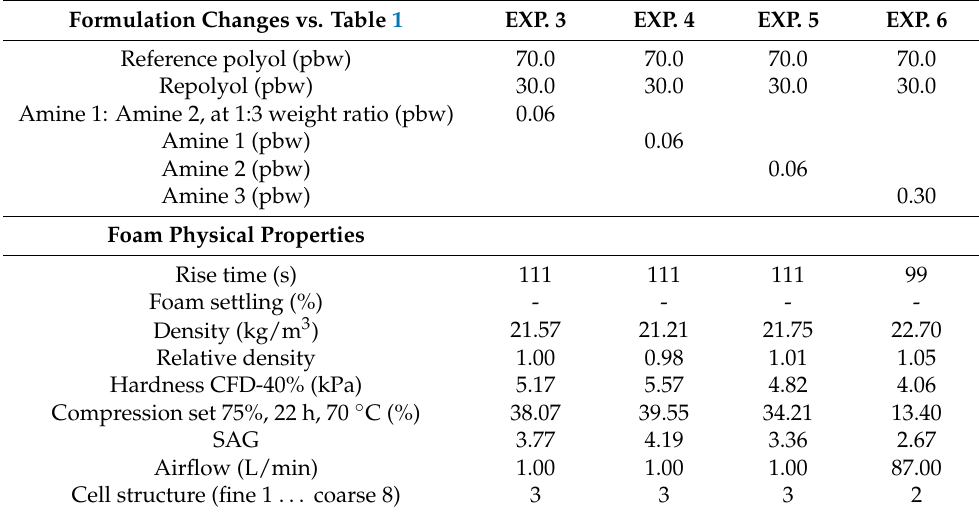
Table 5. The influence of the tertiary amine catalyst on the properties of the flexible PU foams obtained at 70:30 reference polyol:Repolyol